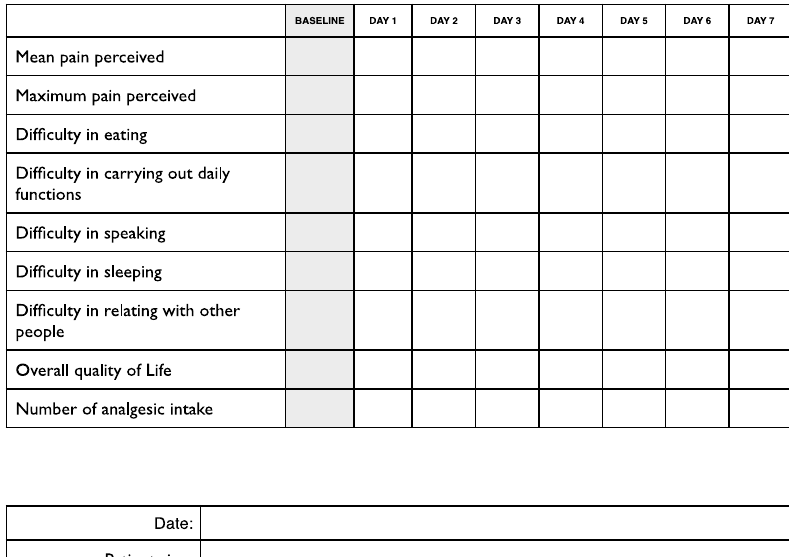
Figure A2. Postoperative Quality of Life